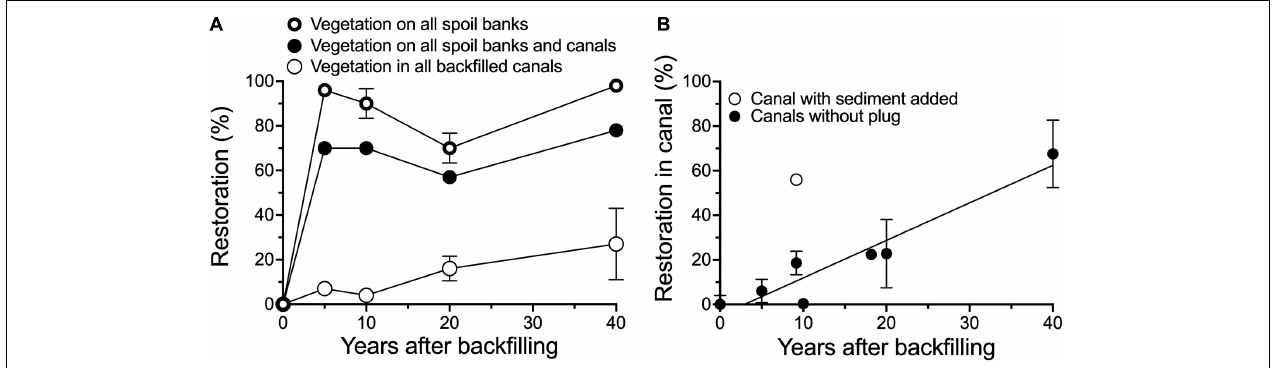
FIGURE 5 | The wetland restoration in the 16 backfilled canals ( µ ± 1 s.e.). (A) Restoration on spoil banks, in canals and total disturbed area for all backfilled canals. (B) The wetland restoration of the differently aged, backfilled canals where there was not a complete plug after backfilling. One canal (open circle) had sediment added as part of the backfilling. A simple linear regression line is shown in (B) . The dots are the mean ± 1 s.e.